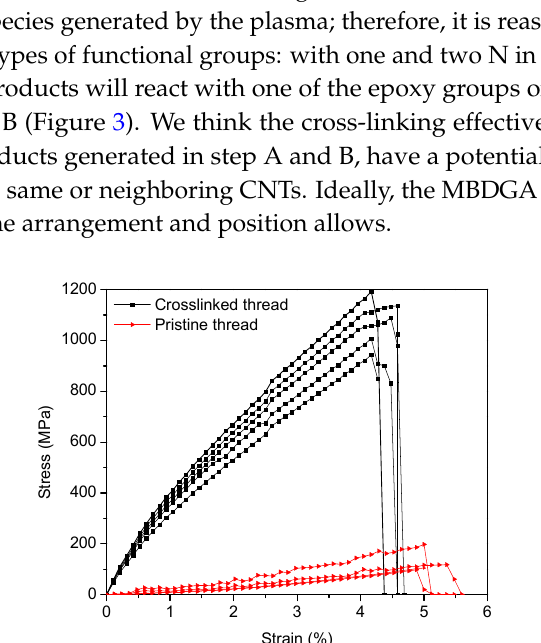
Figure 2. Tensile strength ‐ extension curve of pristine MWCNT thread compared to EDA/MBDGA cross ‐ linked MWCNT thread.